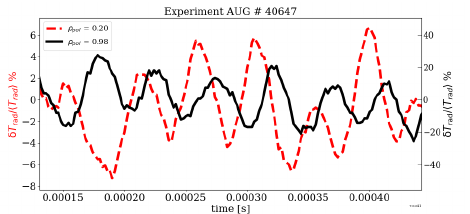
Figure 9. AUG #40647: time evolution of the δ T e / ⟨ Te ⟩ obtained from the raw ECE data in the core ρ pol = 0 . 2 (red) and at the edge at ρ pol = 0.98 (black).